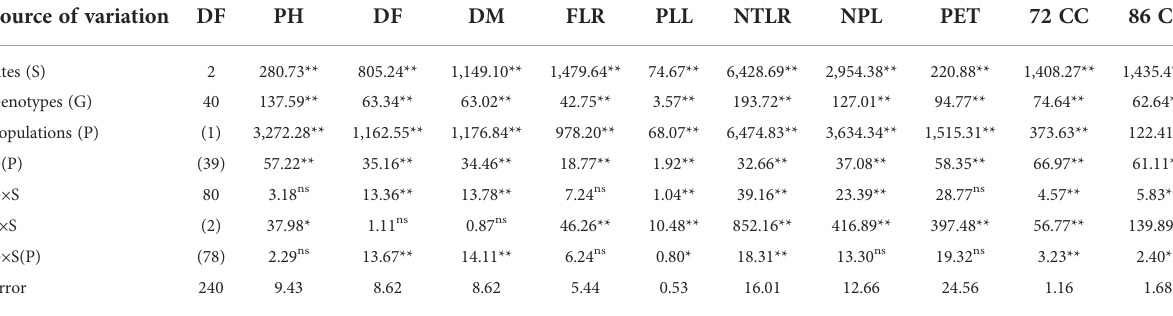
TABLE 5 Vegetative and physiological traits by combined site and populations.